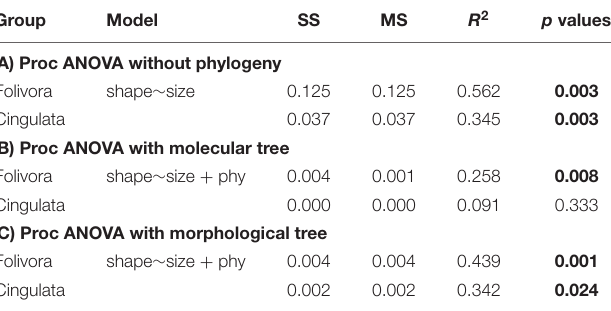
TABLE 3 | Folivora and Cingulata summary statistics for different Procrustes ANOVA models without (A) and with (B, C) accounting for phylogenetic effect. Group